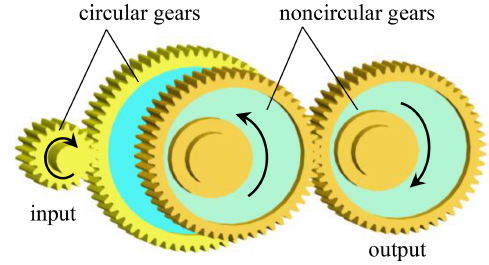
Figure 4. Simplified model of NFG